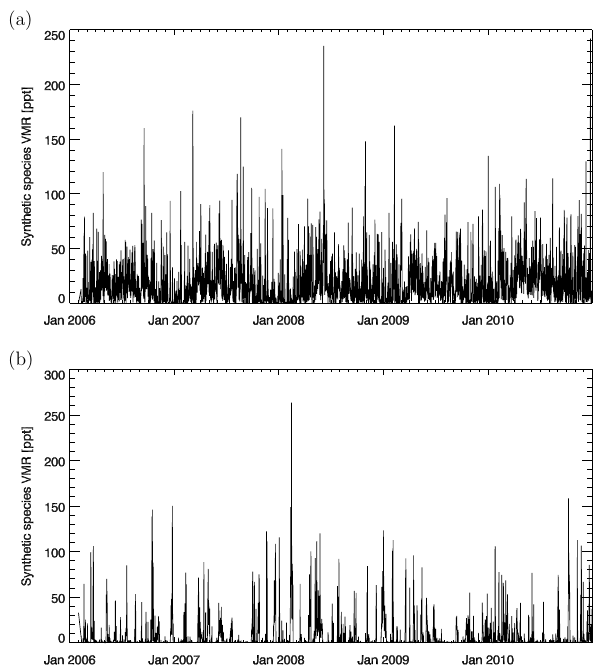
Fig. 4. Time series of the synthetic tracer at Jungfraujoch (a) and Mace Head (b) constructed from the original emission grid.